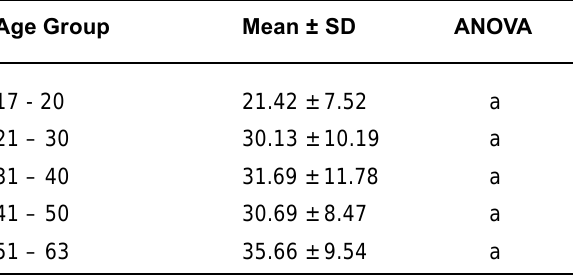
TABLE 3 - Means of tensile bond strength (MPa) to dentin of five age